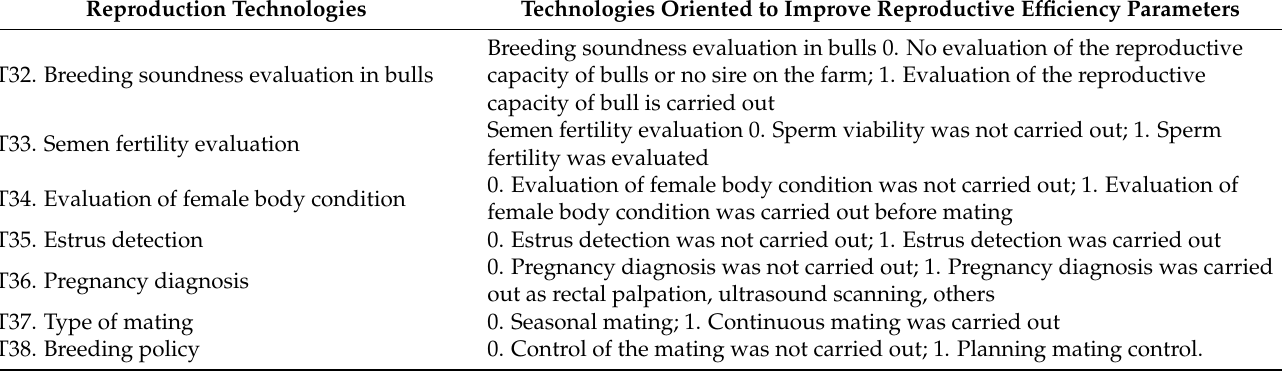
Table 4. Reproduction area technologies description (T, technology